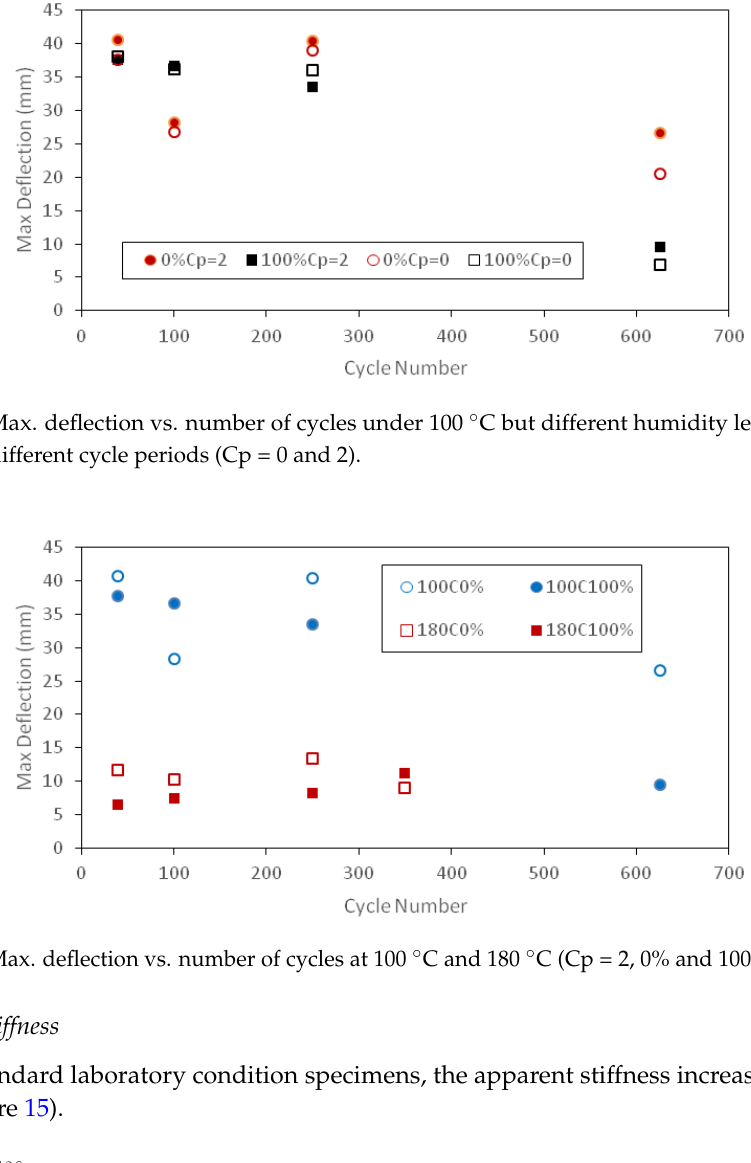
Figure 13. Max. deflection vs. number of cycles under 100 °C but different humidity levels (0% and 100%) and different cycle periods (Cp = 0 and 2).